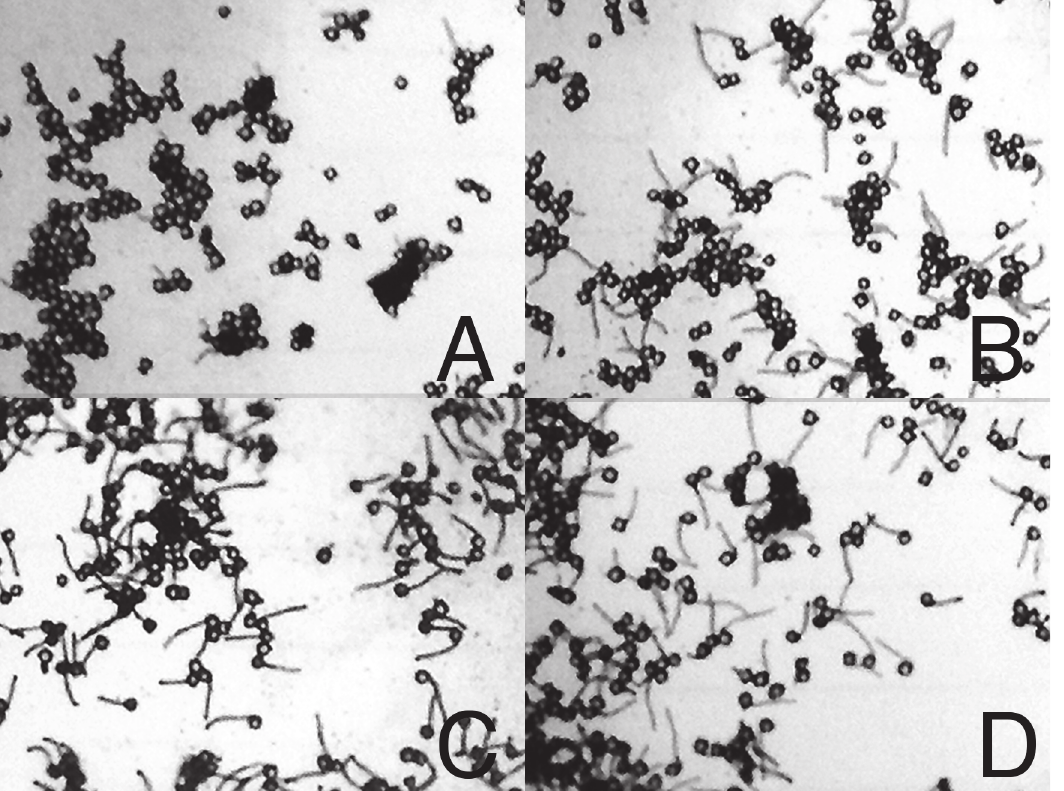
Fig 7. Photomicrographs of tobacco pollen following a high temperature challenge. SR1 (A), SR1-GS2 (B), SR1-GS7 (C), and SR1-GS17 (D) tobacco pollen incubated for 7 minutes at 50°C and then 53 minutes at 30°C.